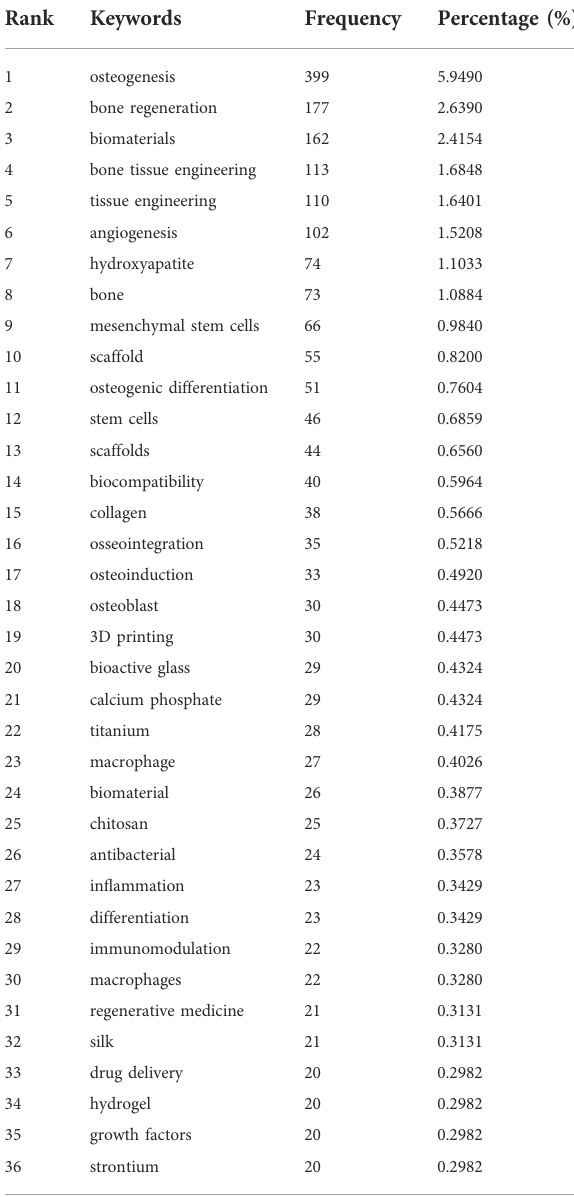
TABLE 6 Keywords of biomaterials research hotspots in